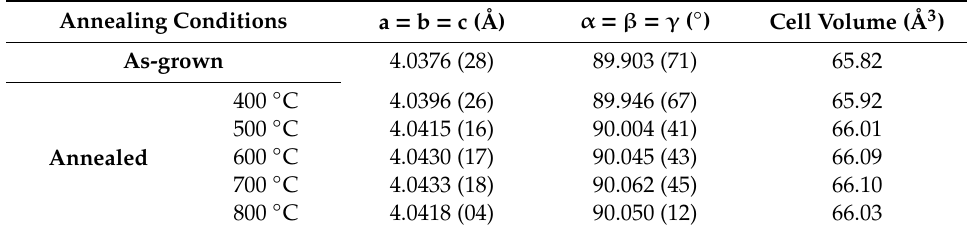
Table 1. Lattice parameters of the Mn:PIMNT crystals.